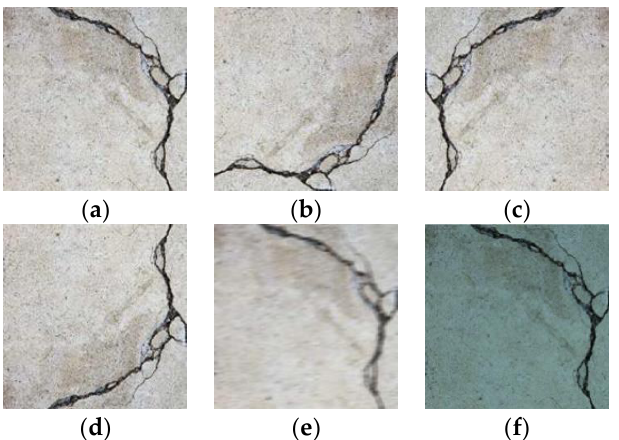
Figure 6. Example of image augmentation: ( a ) Original image; ( b ) rotation 90° to clockwise direction; ( c ) flip left to right; ( d ) flip up and down; ( e ) blur; and ( f ) color conversion.